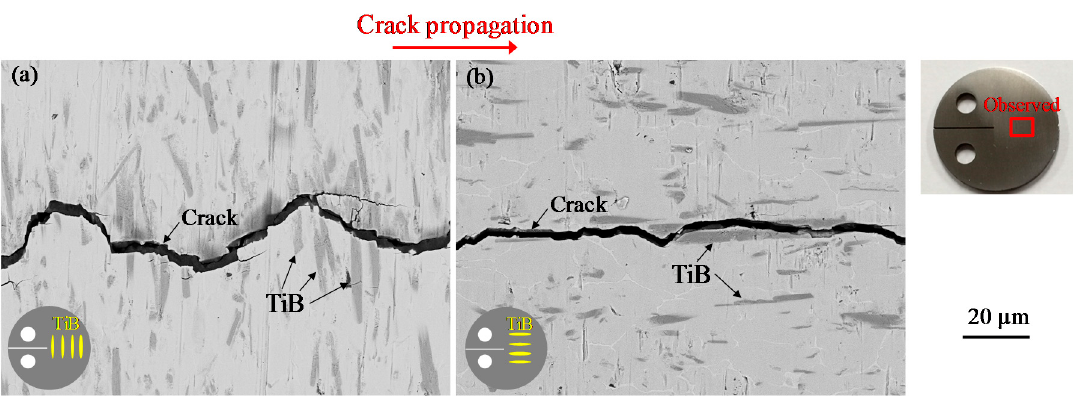
Figure 7. Backscattered electron (BSE) images obtained by SEM observations for crack profiles for ( a ) LT and ( b ) TL series after testing at R = 0.1.